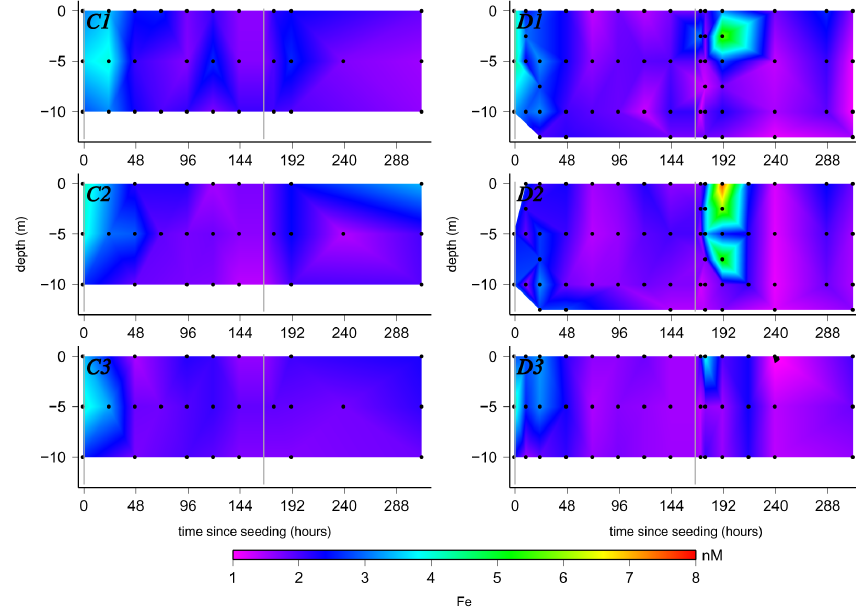
Fig. 2. Evolution of dissolved iron (Fe) in the 6 mesocosms. This graph is plotted in the same way as Fig. 1.